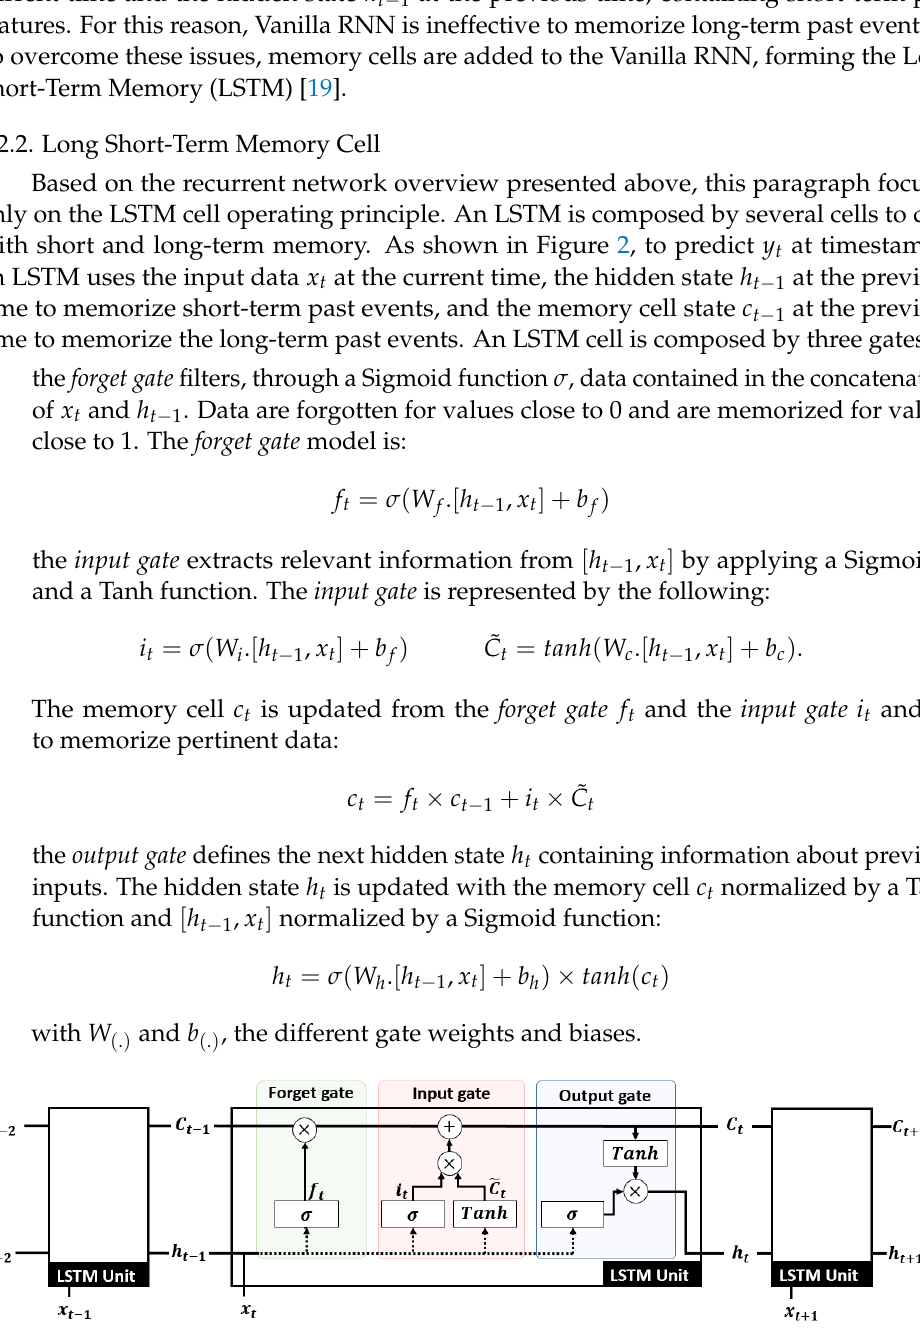
Figure 2. LSTM cell operating principle composed by three